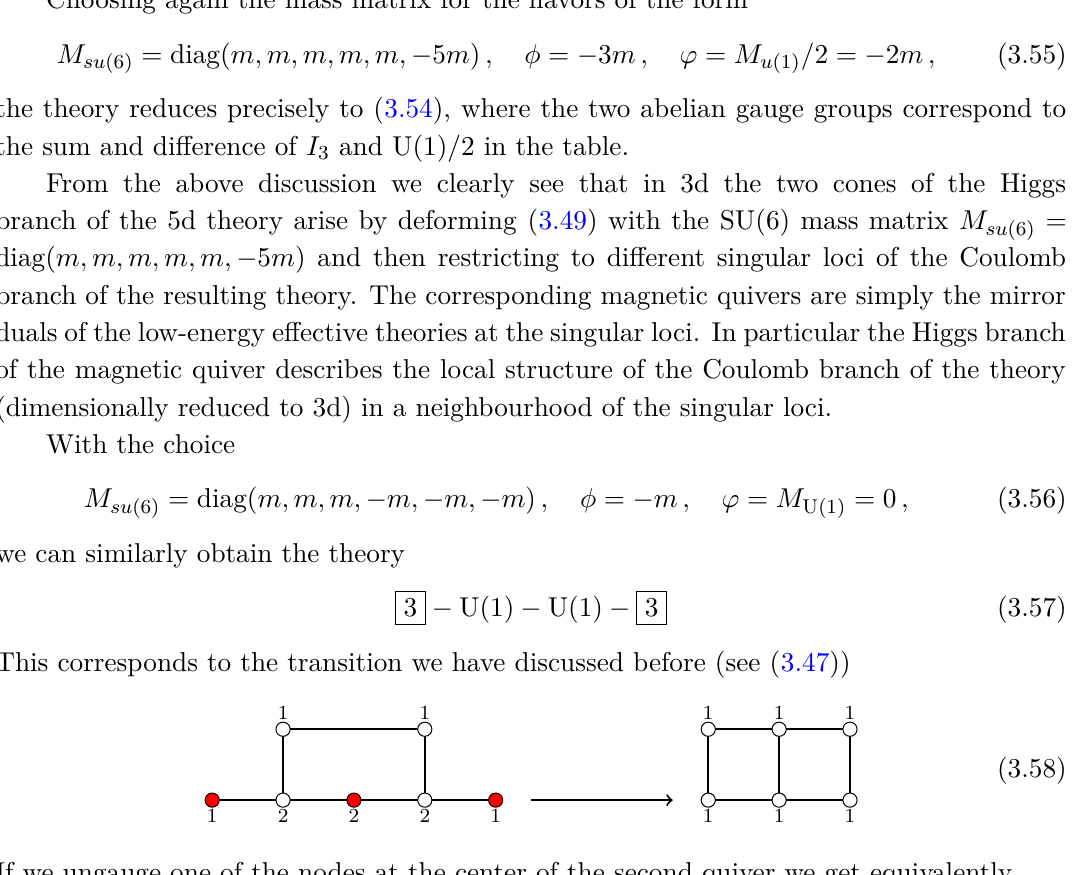
Table 1. Masses and charges of matter fields. B 1 , 2 denote the SU(2) color components of the fundamentals and q the U(1) flavor. I 3 stands for the charge under the Cartan of SU(2) . We also denote with φ the eigenvalue of the SU(2) scalar and with ϕ the vev of the U(1) field. which is achieved by activating a vev for the SU(2) scalar as well. This can of course be diagonalized thus breaking the gauge symmetry to the Cartan subgroup. For ease of presentation we collect the charges of the various matter fields in table